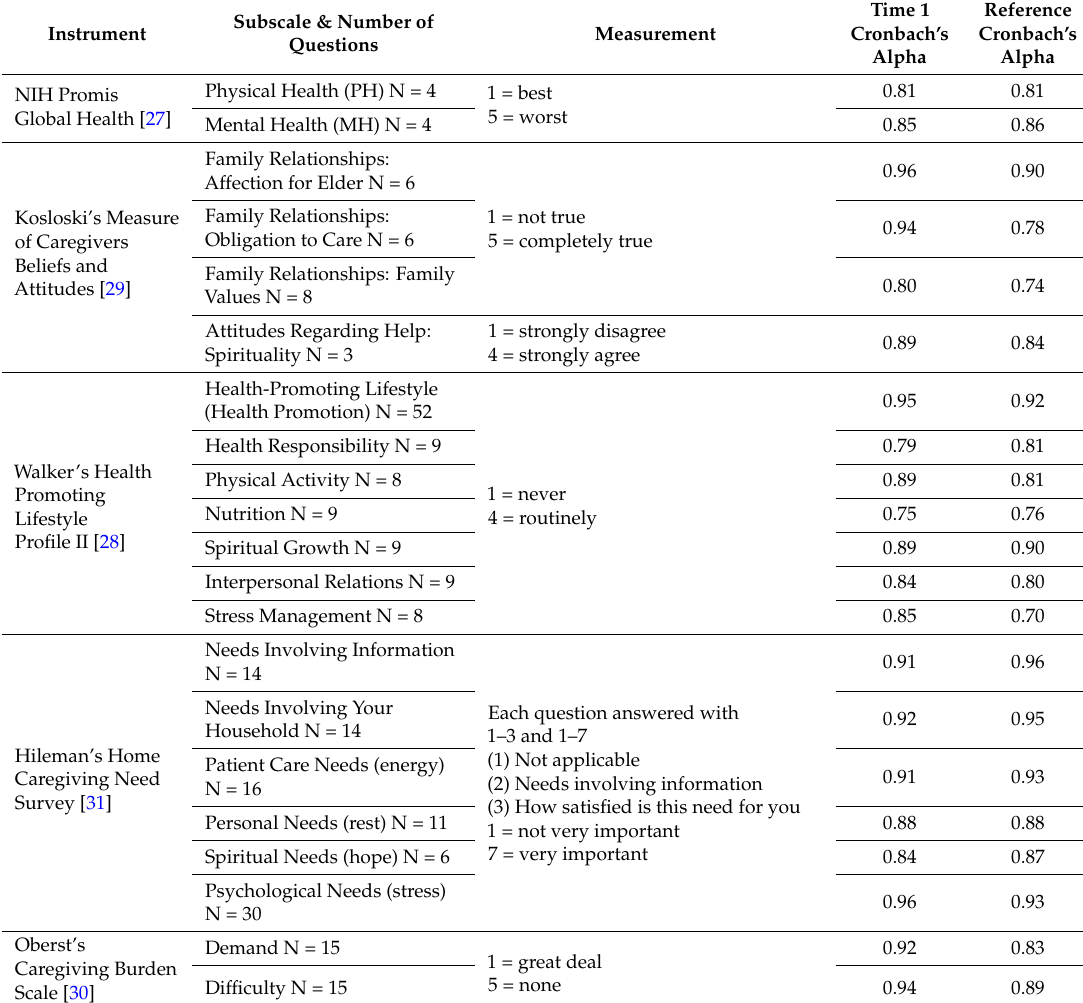
Table 1. Instrument